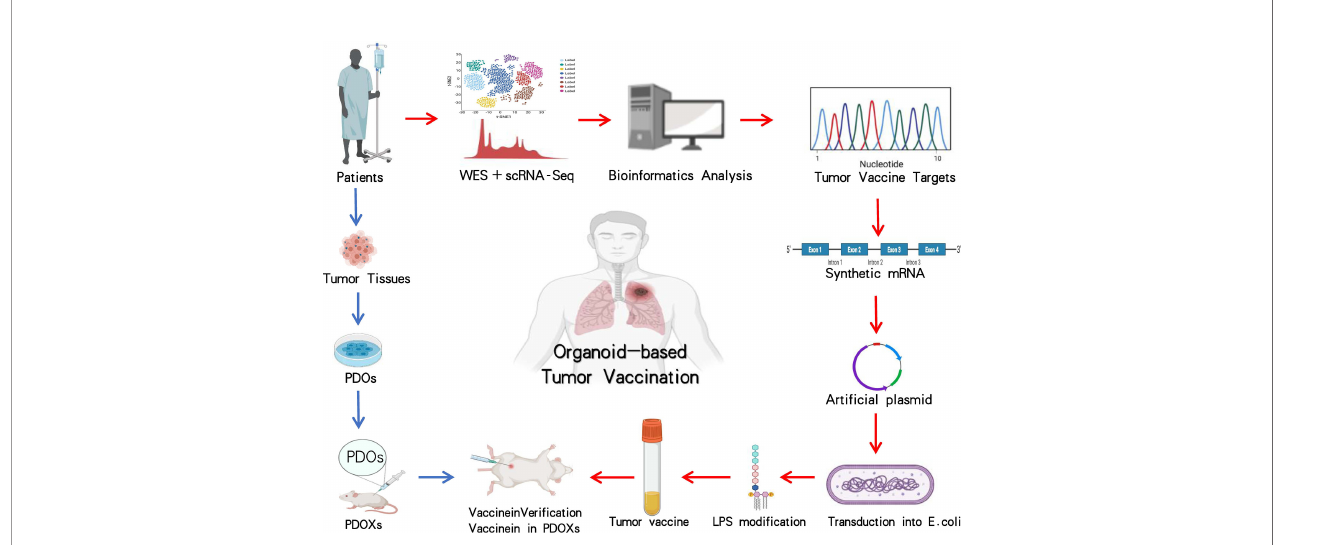
FIGURE 3 | Application and investigation of organoid-based tumor vaccination. The work fl ow with blue arrows represents the patient-derived organoid xenograft (PDOX) model, and processes with red arrows indicate how tumor vaccine is generated. The entire steps are to verify the ef fi cacy of tumor vaccination by using the PDOX model. Images are adapted from Servier Medical Art